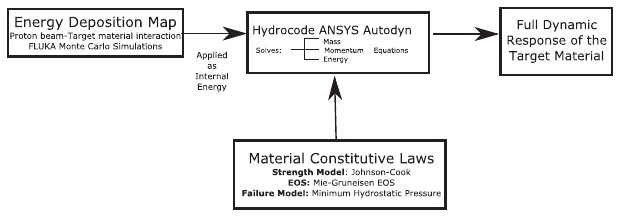
FIG. 2. Scheme of the methodology employed in this study, including the two computational tools FLUKA and ANSYS AUTODYN ®